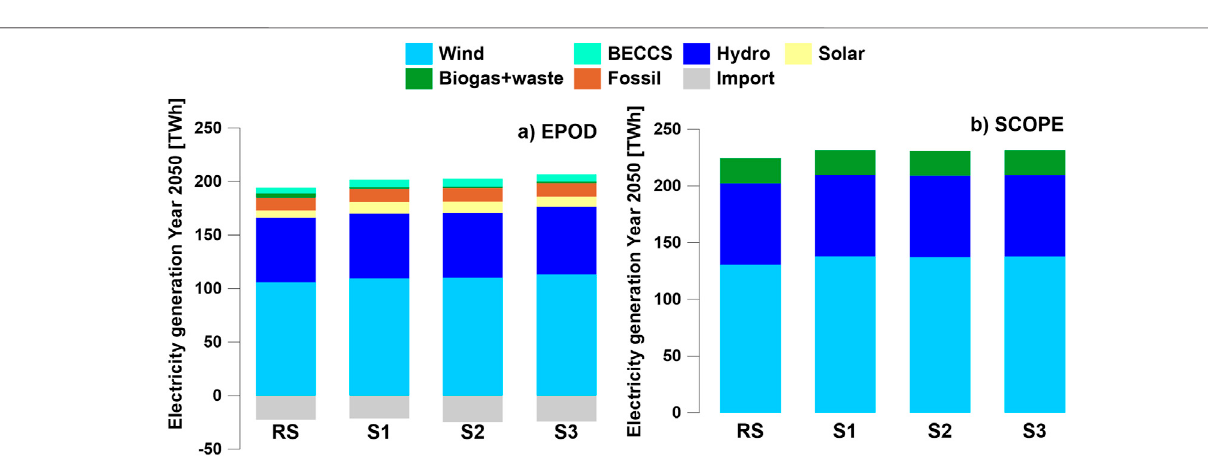
Frontiers in Energy Research |